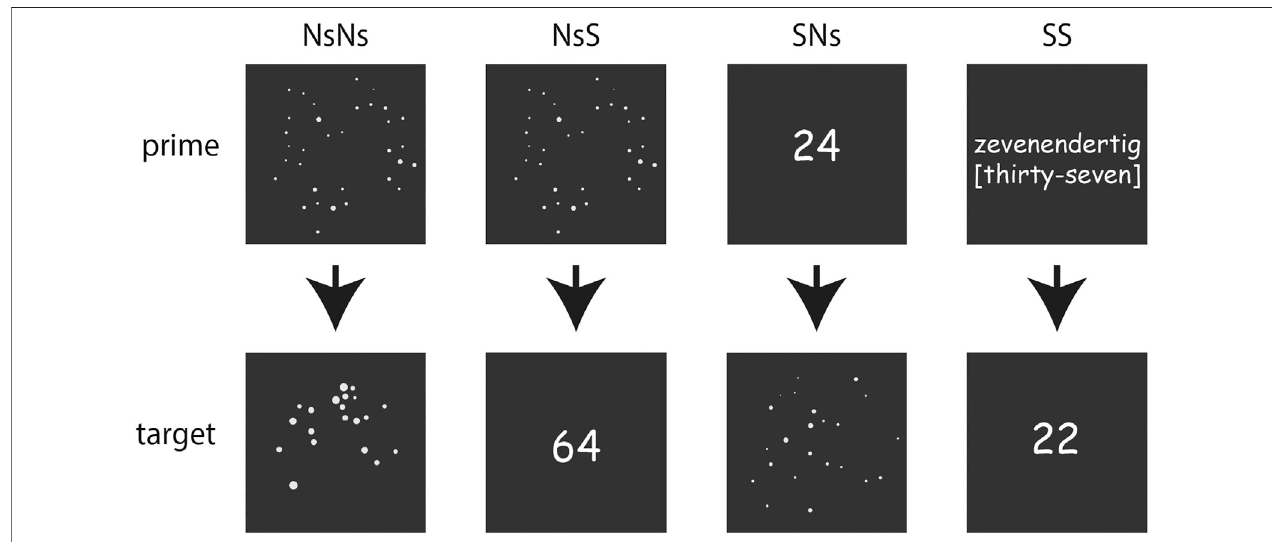
FIGURE 1 | Overview of the stimuli-formats in the different tasks with the upper line presenting the primes for each task, and the lower line presenting the targets.